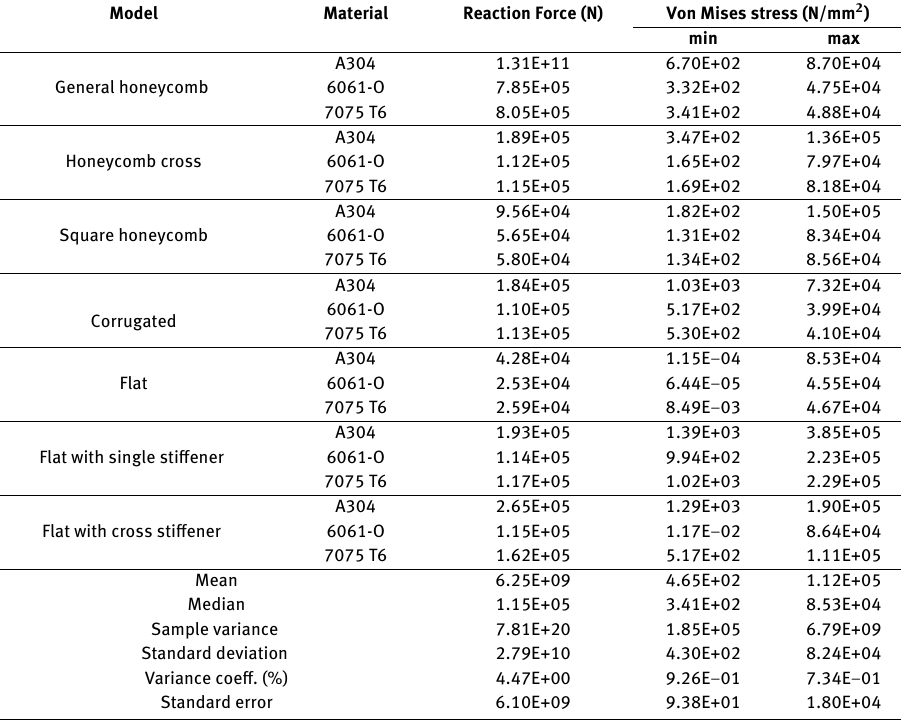
Table 3: Summary of the von Mises stress and reaction force results